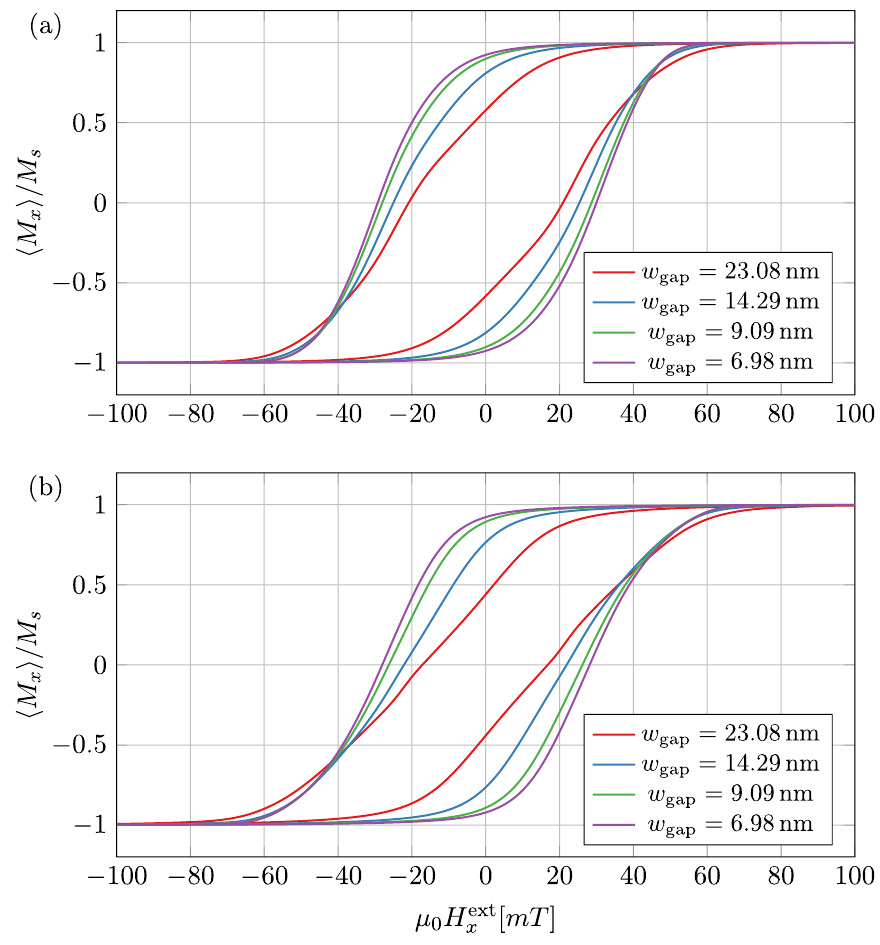
Figure 6. Hysteresis curves of the SMC material for varying interparticle widths w gap using true PBCs implemented with the ( a ) FE method and ( b ) FD method.